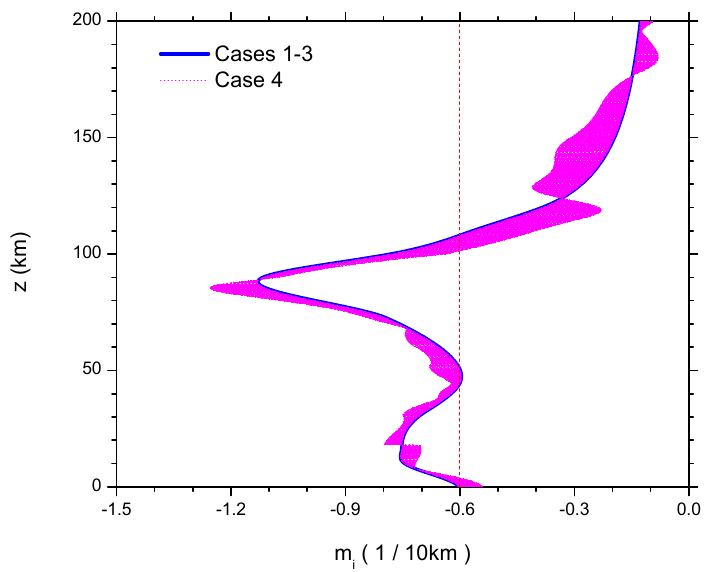
Figure 3. Imaginary vertical wavenumber, m i (1/10 km), of different tsunami-excited wave modes propagating in an atmosphere. Case 1: Hines’ locally-isothermal and shear-free model; Case 2: the extended Hines’ model under nonisothermal conditions; Case 3: inertio-acoustic-gravity waves under nonisothermal conditions; Case 4: acoustic-gravity waves under nonisothermal and wind shear conditions. In Cases 1–3, m i -curves are superimposed upon each other (in blue); in Case 4, the m i -band fluctuates upon those of Cases 1–3 (in pink). As a reference, a red straight line is shown in the figure to represent the result of m i for an ideal atmosphere, which is isothermal at all altitudes in response to the constant T 0 in Figure